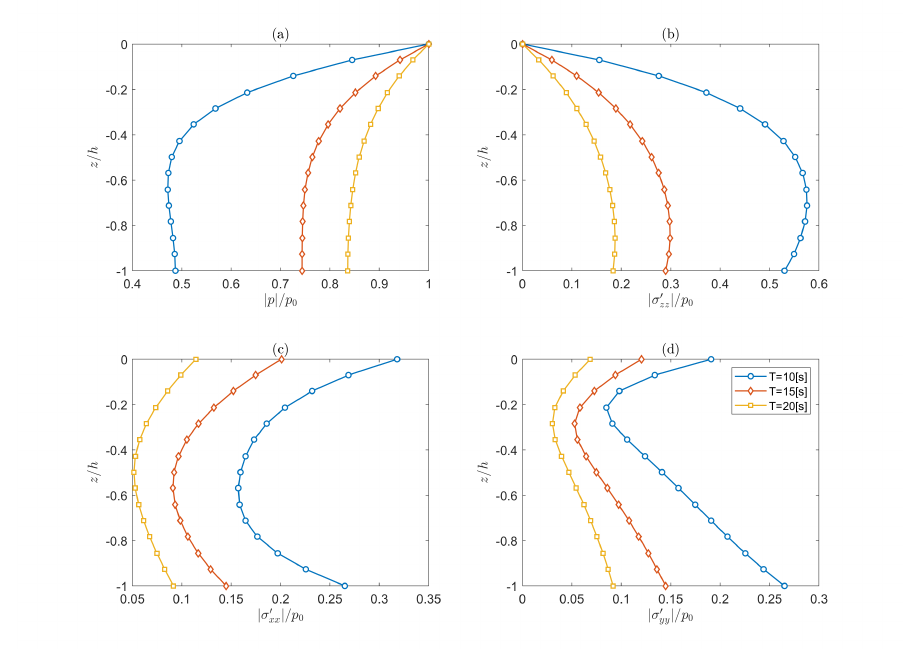
Figure 4. Effect of wave period on ( a ) pore pressure p and effective stresses ( b ) σ (cid:48) zz , ( c ) σ (cid:48) xx , and ( d ) σ (cid:48) yy along the z -axis for anisotropic permeability ( T = 10,15, and 20 s correspond respectively to Cases 1, 2, and